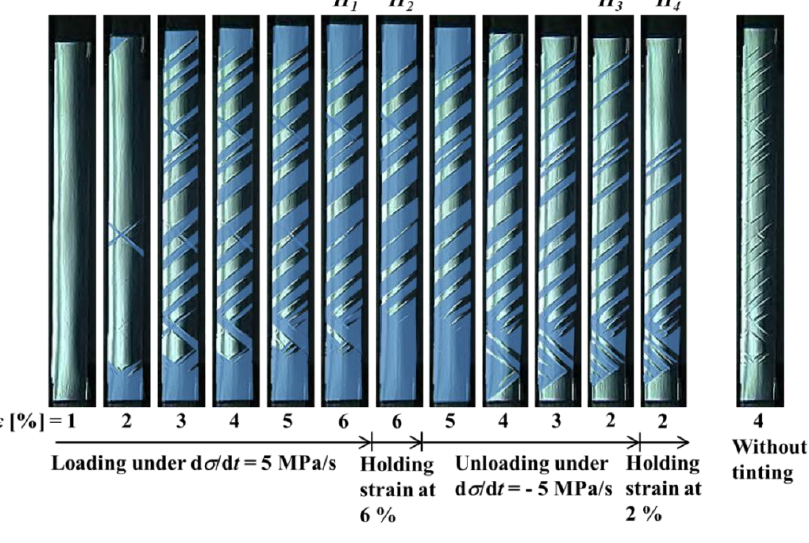
Figure 5. Photographs of specimen surface at various strains ε under a stress rate of 5 MPa/s followed by holding strain constant at a point H point H (ε = 2%) during 3 3